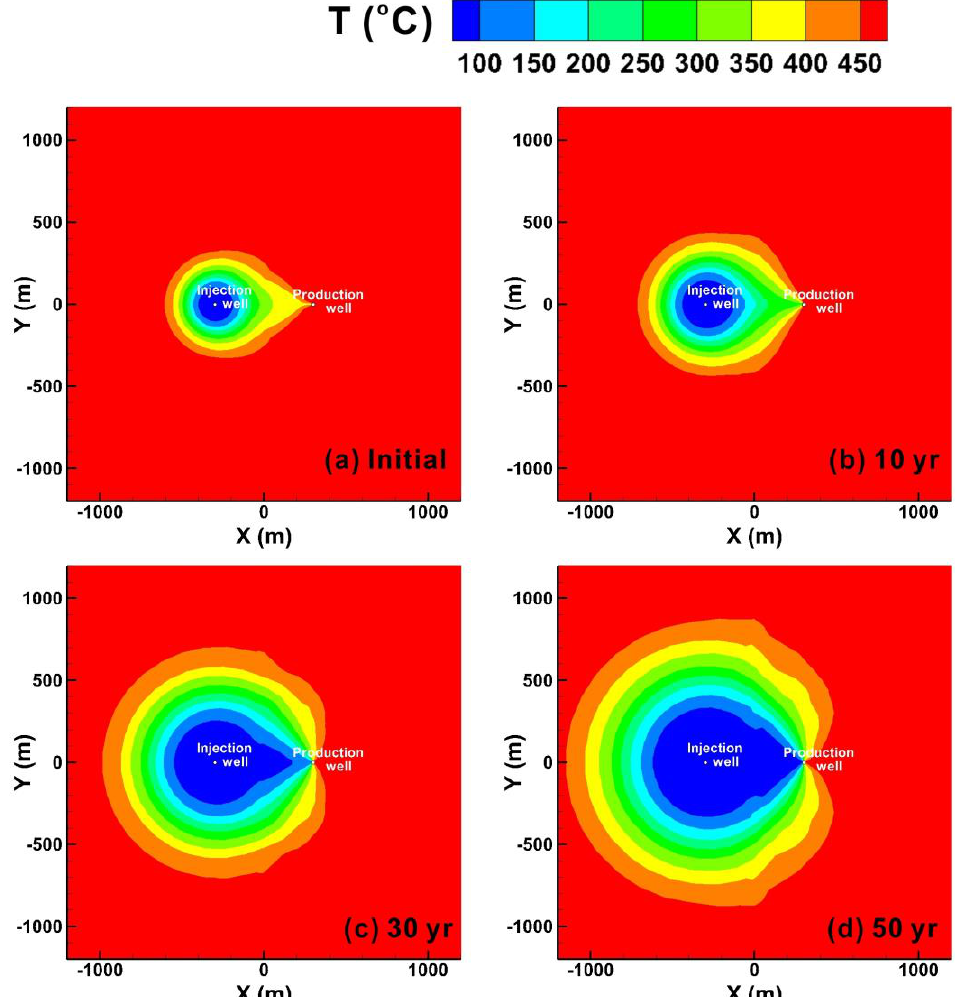
Figure 4. The reservoir temperature distribution at different times.